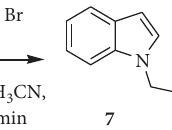
Scheme 3: Synthesis of N-alkylated indole 7